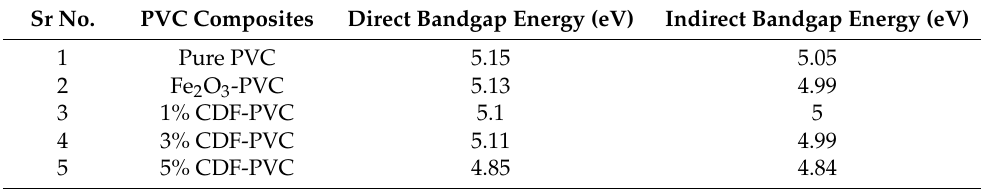
Table 2. Direct and indirect bandgap energies of PVC composites. Sr No.